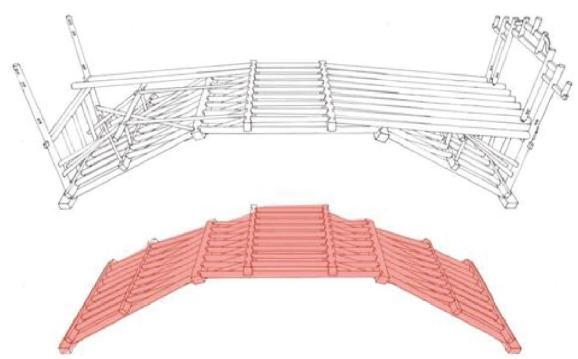
Figure 2: “Wood weaving” structure